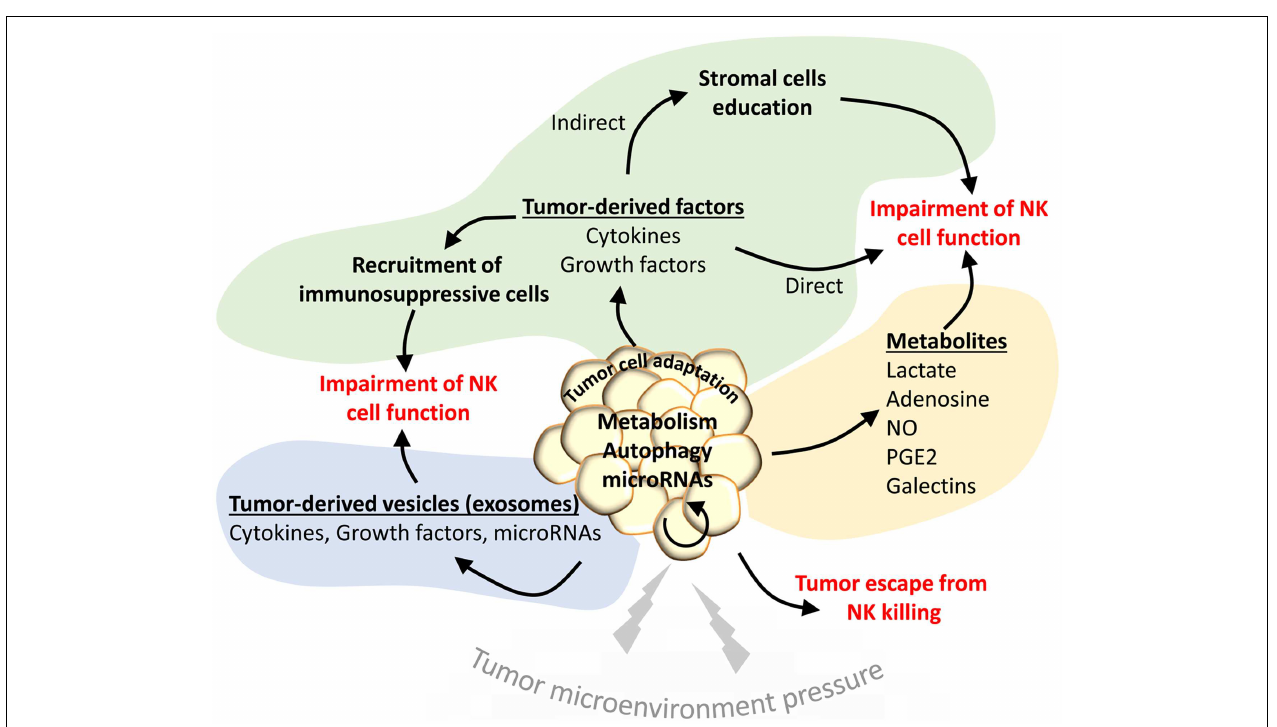
(yellow area).Tumor cells under stress conditions may activate the release of tumor-derived vesicles containing cytokines, growth factors, or microRNAs to directly impact the NK functions (blue area). Such factors can be secreted directly in theTME to recruit immunosuppressive cells or to educate stromal cells involved in the impairment of NK cell functions (green